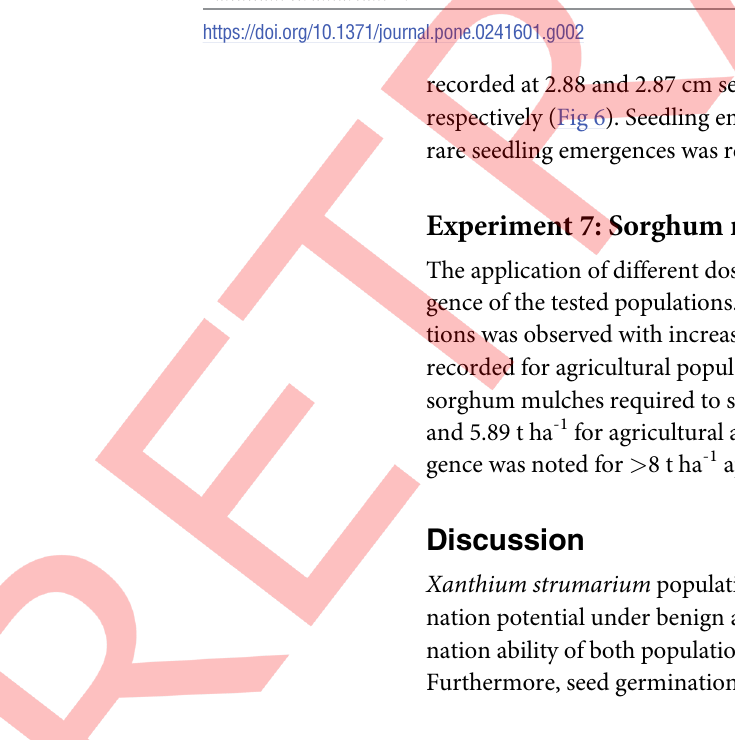
Fig 2. The influence of different constant temperature regimes on seed germination percentage of ruderal and agricultural populations of Xanthium strumarium